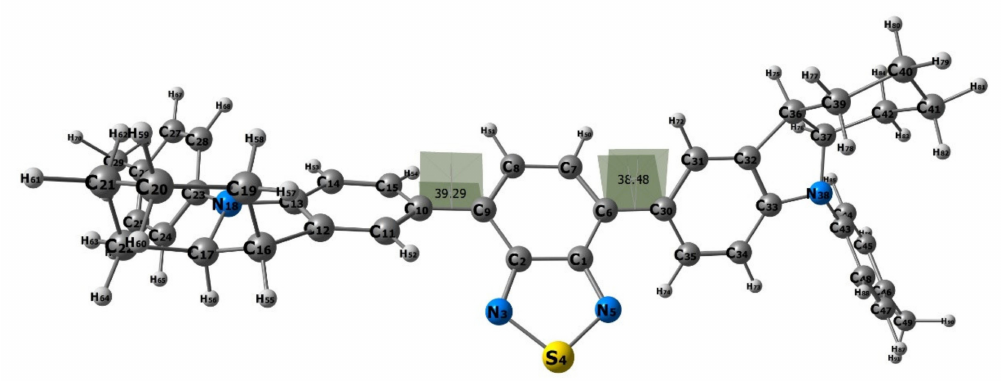
Figure 5. The selected dihedral angles of compound 1b in THF solvent at ground state.